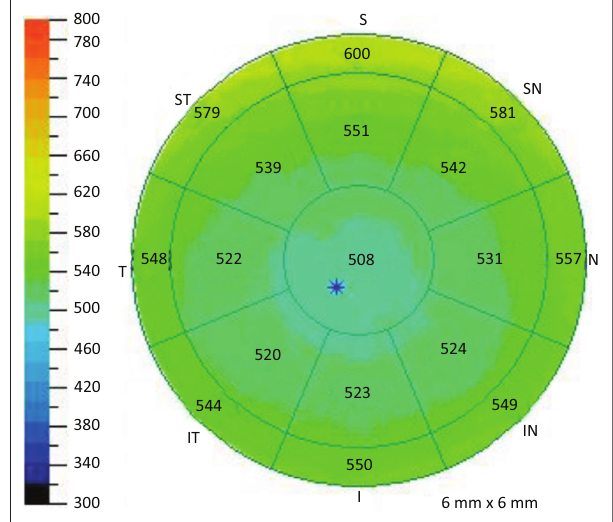
Source : iVue 100 spectral domain optical coherence tomographer (Optovue, Inc.) FIGURE 1: Corneal pachymetry